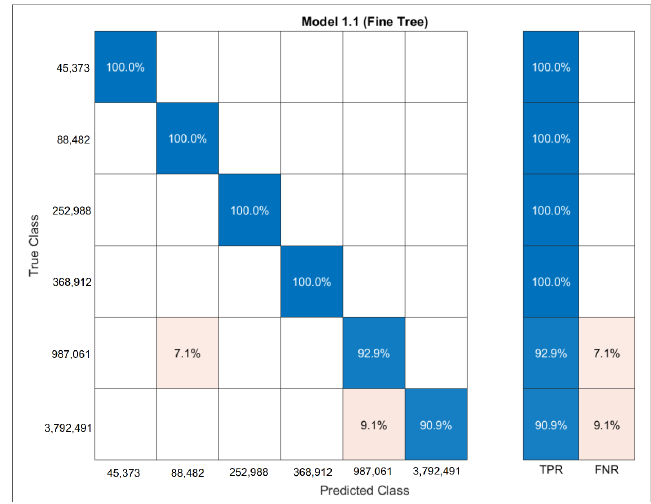
Figure 11. Framework resolution prediction